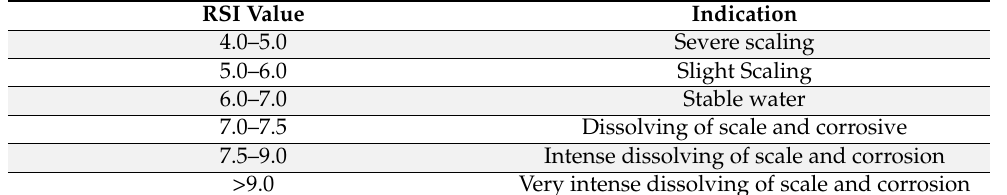
Table 1. Interpretation of the RSI